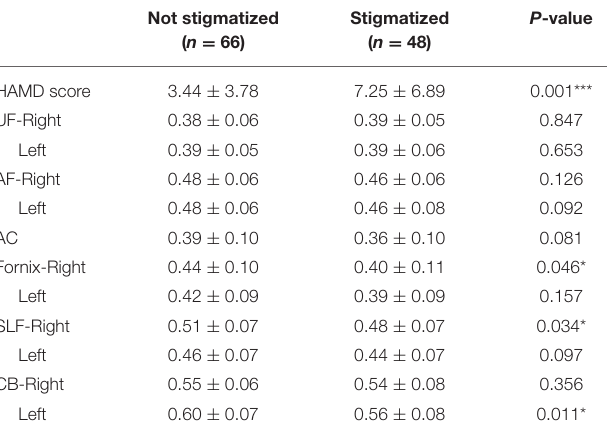
TABLE 4 | Relations between felt stigma and HAMD, FA values of frontotemporal contact fibers.